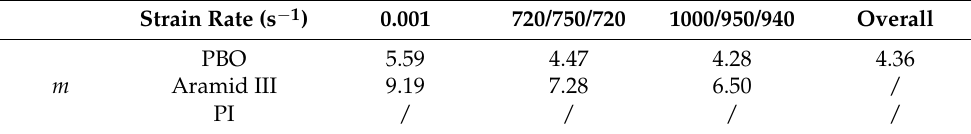
Table 3. Shape parameters of the Weibull distribution for different single